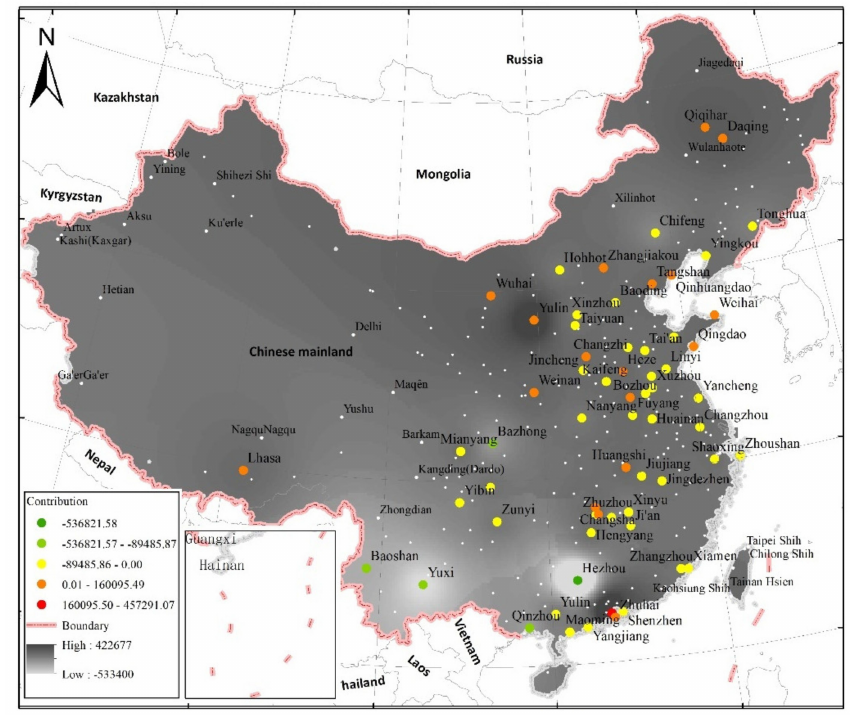
Figure A5. Contribution from the indicator RoadDensity (road area on land per Km 2 ) to land-use intensity revealed in the city-based